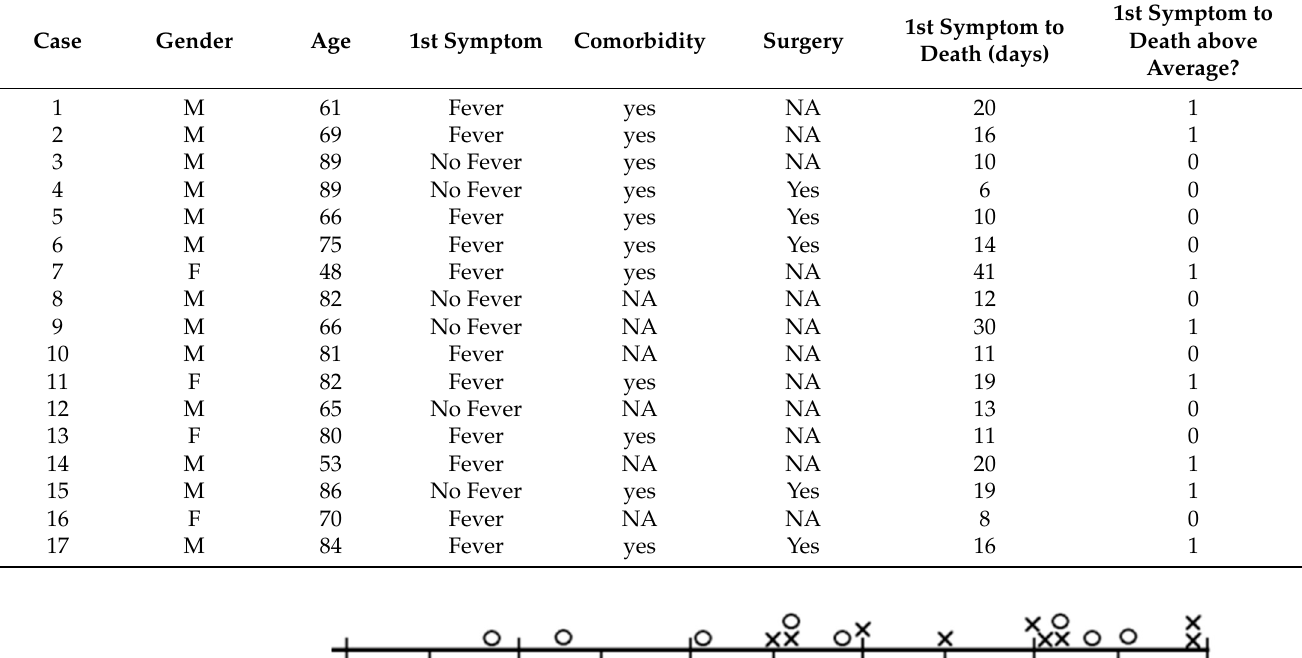
Table 1. The first 17 rows of a data set with COVID-19 deaths, adapted from [82].